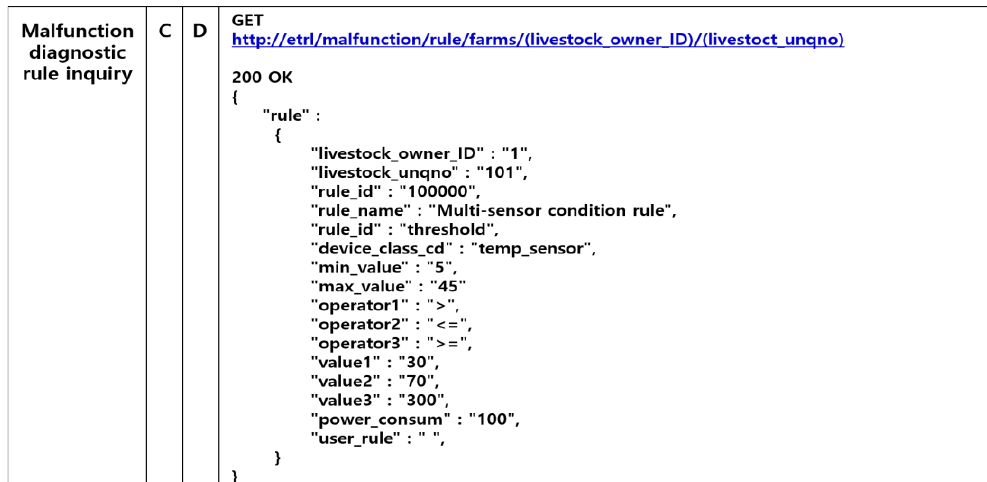
Figure 6. Example of a system interface for users to diagnose device malfunctions through the cloud.